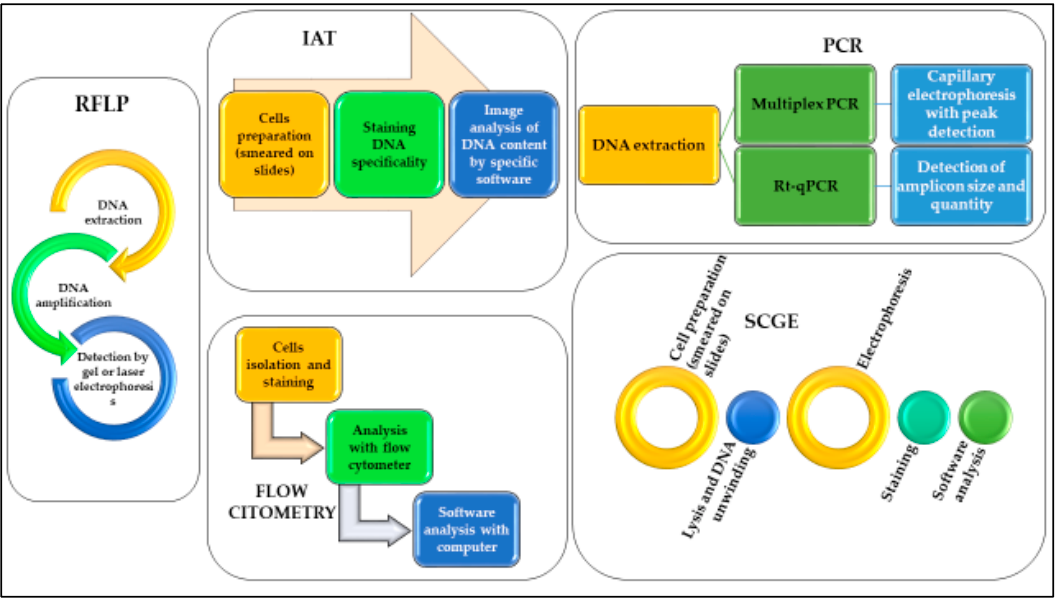
Figure 1. Schematic representation of the workflow necessary to use DNA analyses for the different methods described.